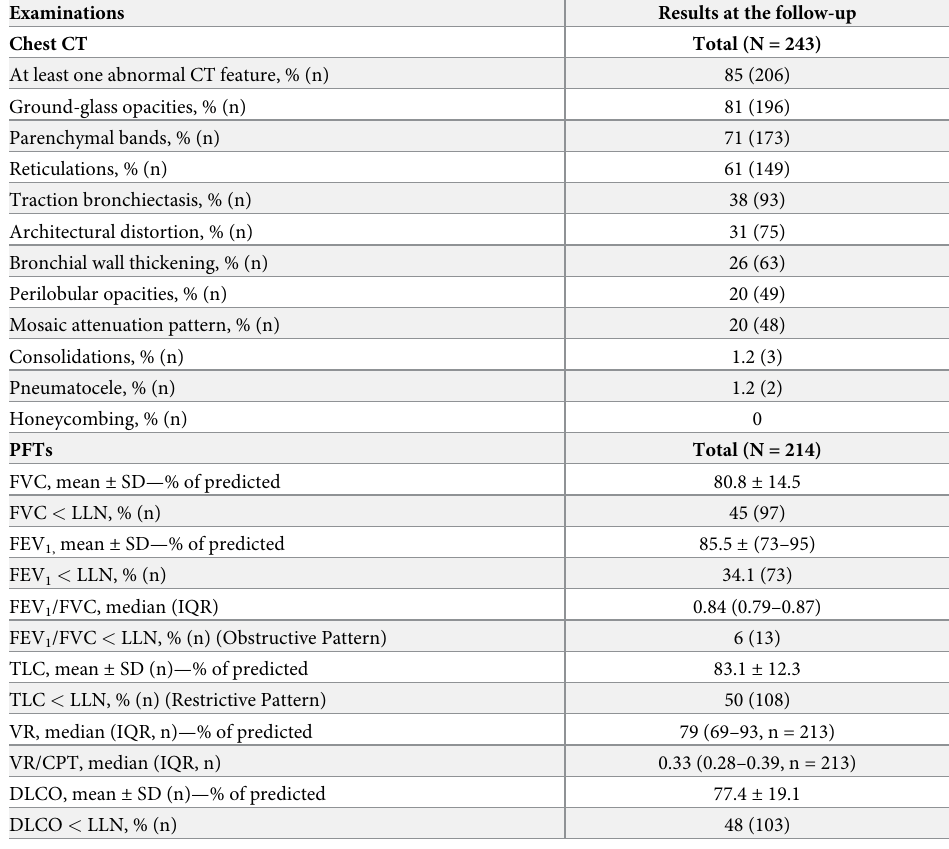
Table 2. Chest CT and PFTs among COVID-19 survivors at the follow-up. Examinations Results at the follow-up Chest CT Total (N = 243) At least one abnormal CT feature, % (n) 85 (206) Ground-glass opacities, % (n) 81 (196) Parenchymal bands, % (n) 71 (173) Reticulations, % (n) 61 (149) Traction bronchiectasis, % (n) 38 (93) Architectural distortion, % (n) 31 (75)